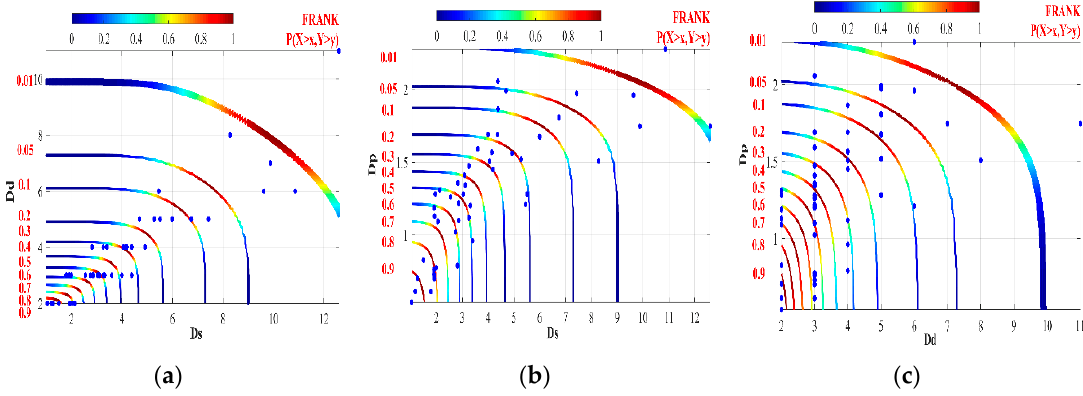
Figure 7. The joint probability Tajikistan drought variables from 1961 to 2017: ( a ) Ds-Dd; ( b ) Ds-Dp; ( c ) Dd-Dp.